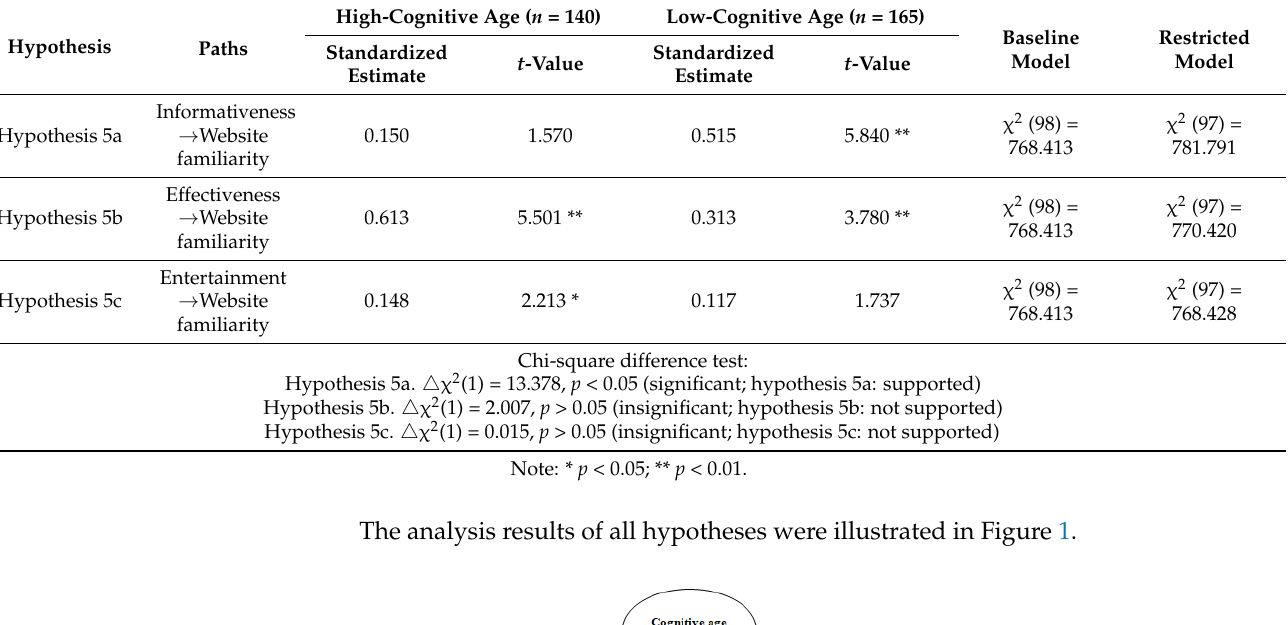
Table 5. Moderating effect test.